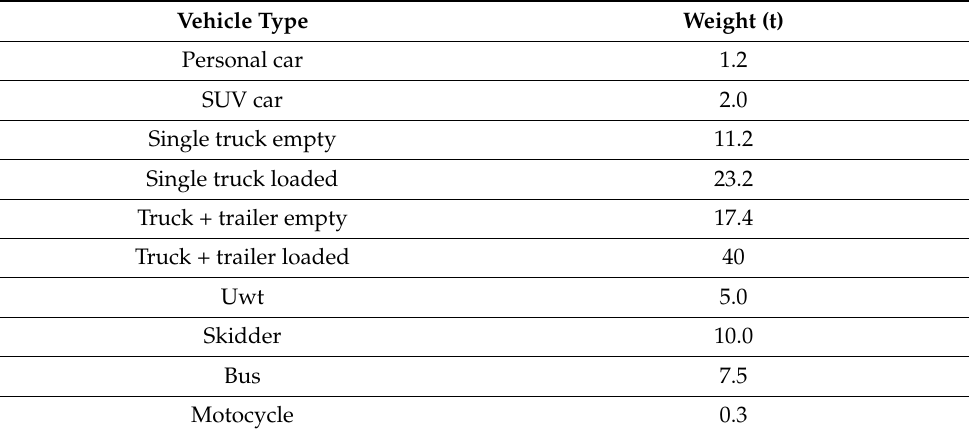
Table 2. Weights of vehicles according to a vehicle